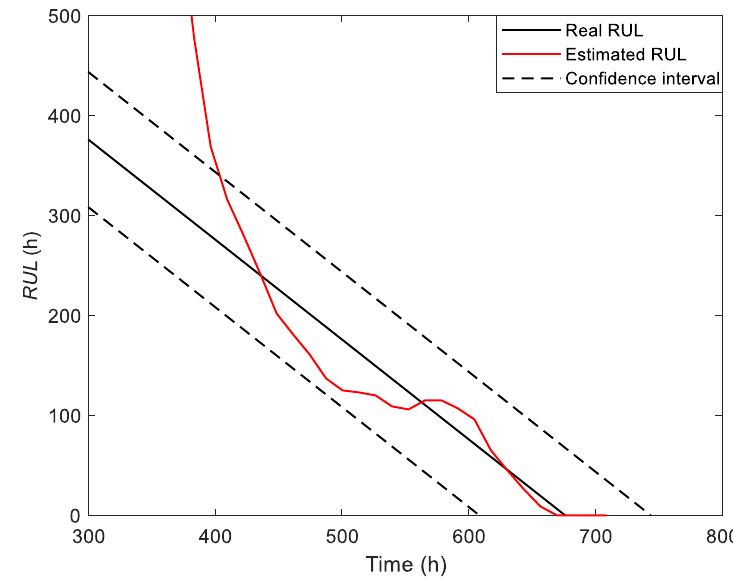
Figure 10. RUL estimation.